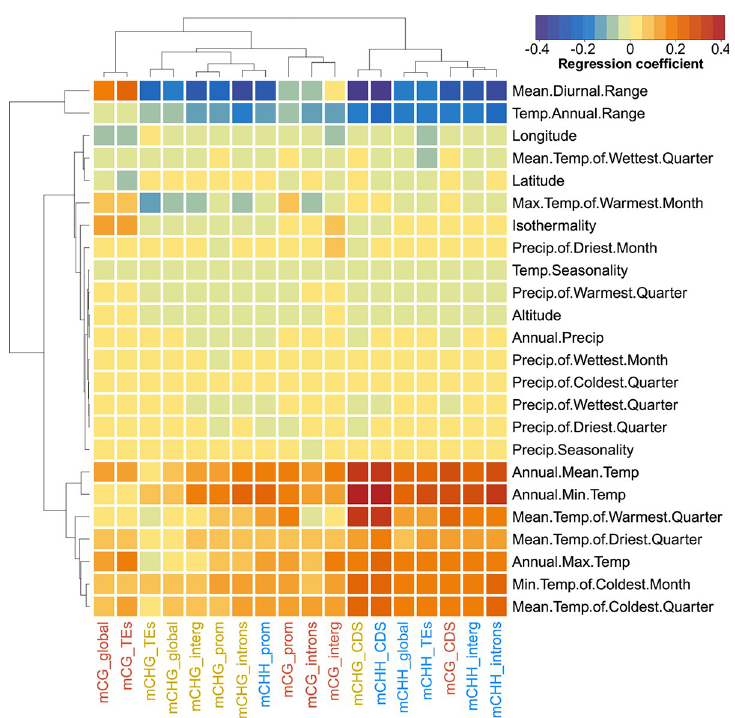
Fig 4. Climate-methylation associations. A Heatmap of the correlations between mean methylation and different climatic variables (Precip: precipitation; Temp: temperature), separately for different sequence contexts and genomic features (prom: promoter; interg: intergenic; TEs: Transposable Elements; CDS: coding sequences). Both rows and columns are clustered by their multivariate similarity in association